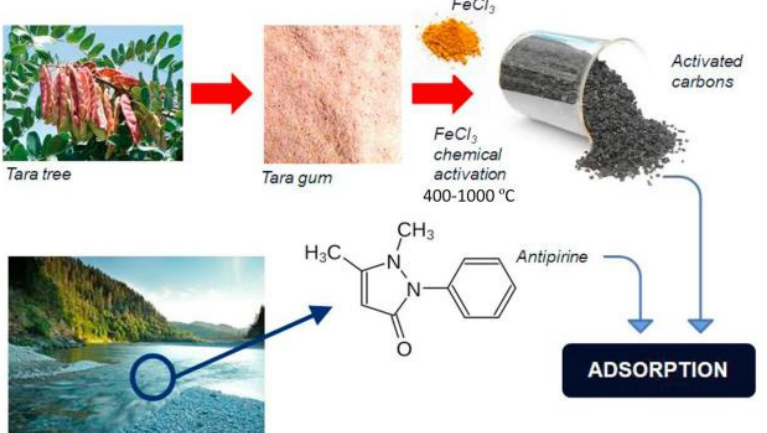
Figure 13. Preparation process of Tara gum-derived activated carbon and its application for adsorp- tion antipyrine in water [242].